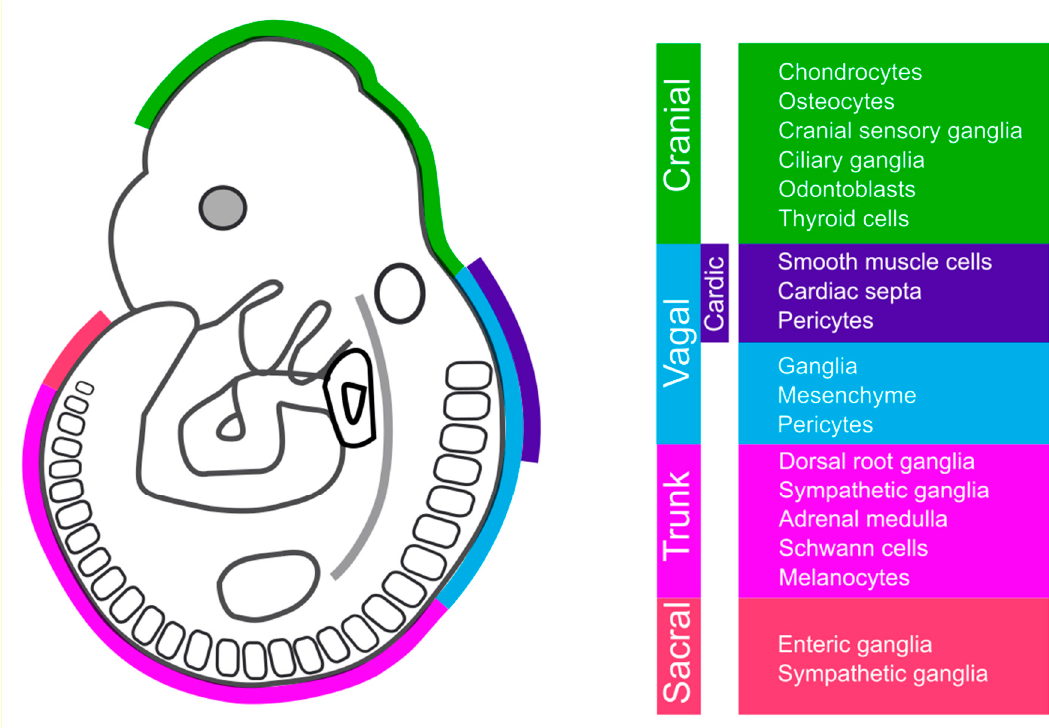
Figure 1. Anatomically distinct neural crest cell populations and their major derivates. Schematic lateral view of a mouse embryo at embryonic day 9.5 shows the cranial ( green ), vagal ( azure ), trunk ( purple ), and sacral ( ruby ) neural crest cells and their major derivatives. Vagal segment includes cardiac neural crest ( indigo ).